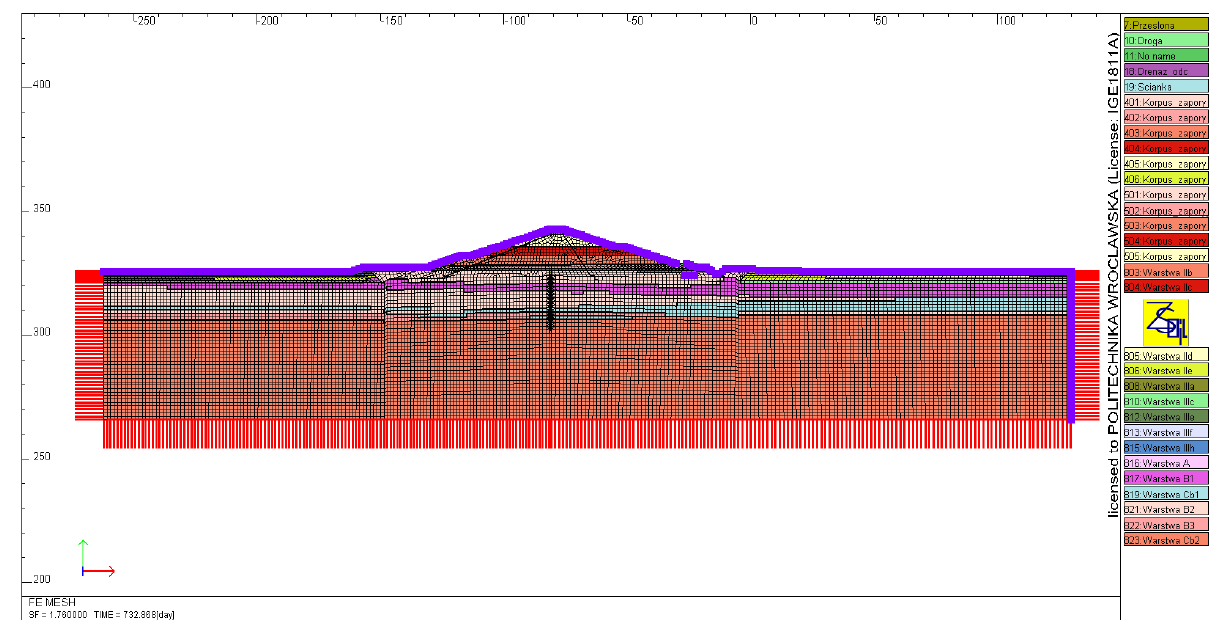
Figure 11: Numerical model created for the purpose of deformation and stability